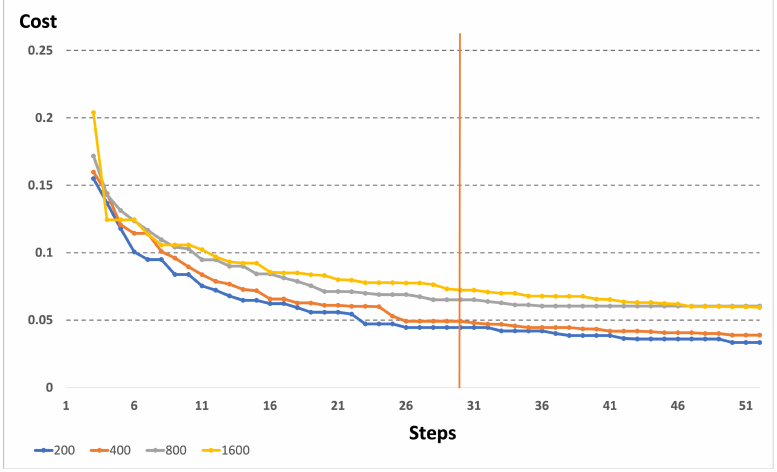
Figure 9. AC for the low-cost bounded degree spanning tree algorithm after 50